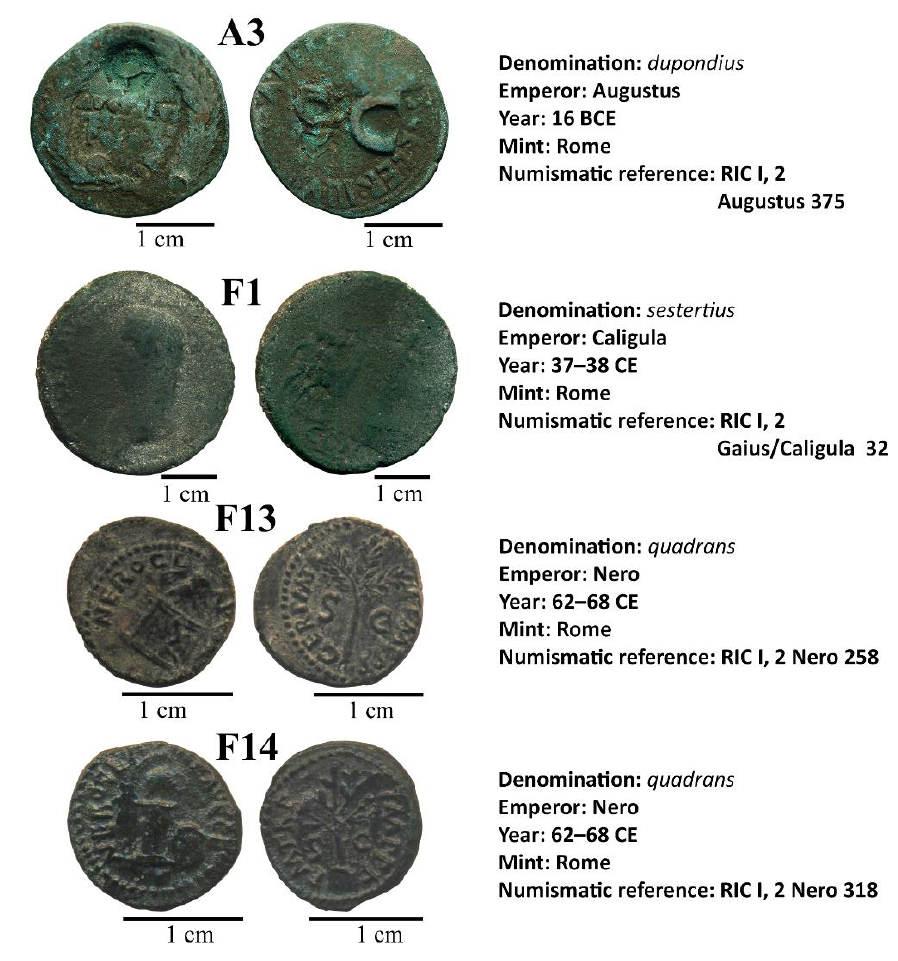
Figure 1. Images of the studied coins (reverse and obverse), from private collections, and their numismatic information .